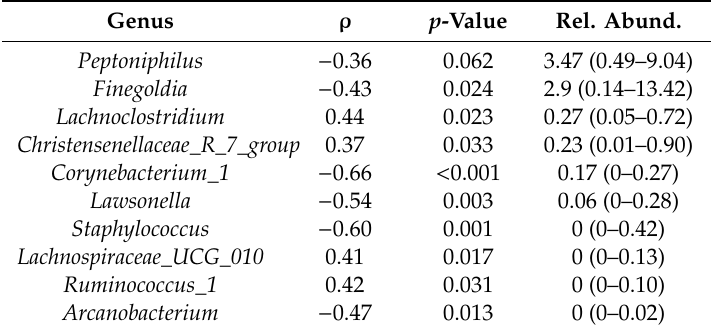
Table 2. Spearman correlation between the salivary cortisol concentration and maternal microbiota at delivery. Genus ρ p -Value Rel. Abund. Peptoniphilus − 0.36